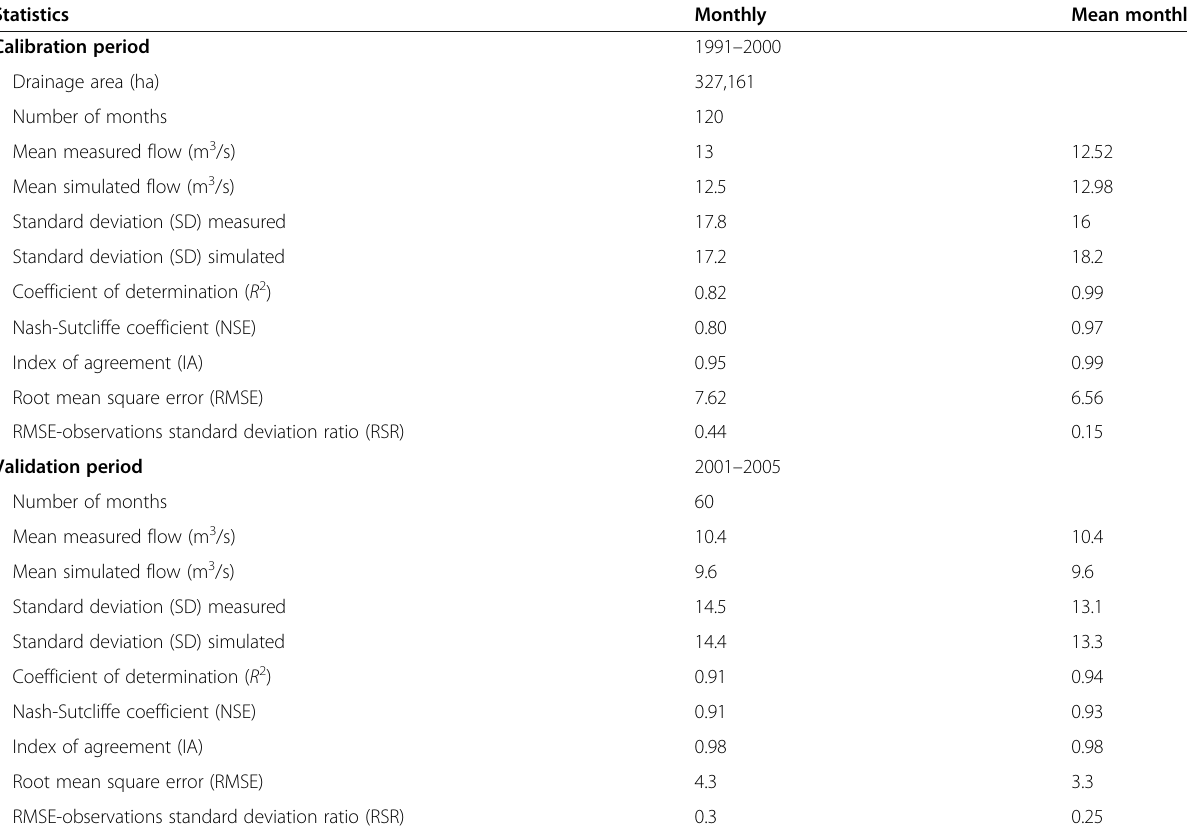
Table 4 Summary of model performance statistics for measured and simulated the Ketar monthly and mean monthly streamflow at Abura gauging